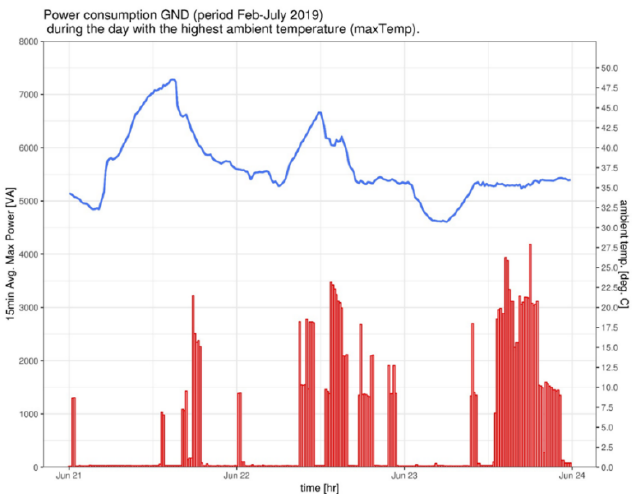
Figure 15. The 15-min average max power demand (GND) in relation to 15-min mean ambient temperature (blue line) for the day with the max temperature in the measurement period.